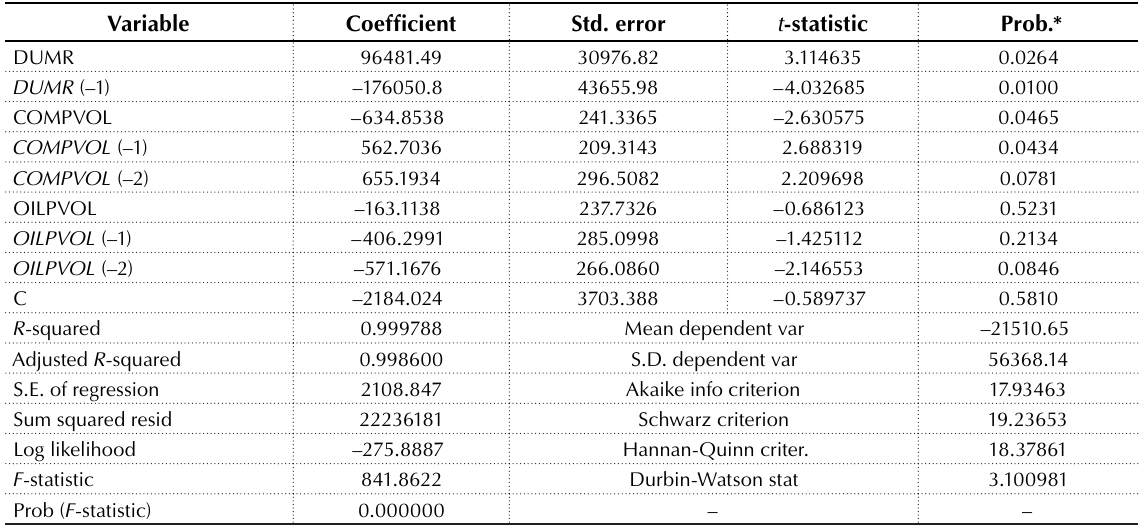
Table 14 (cont.). ARDL regression for fiscal policy shocks and fiscal